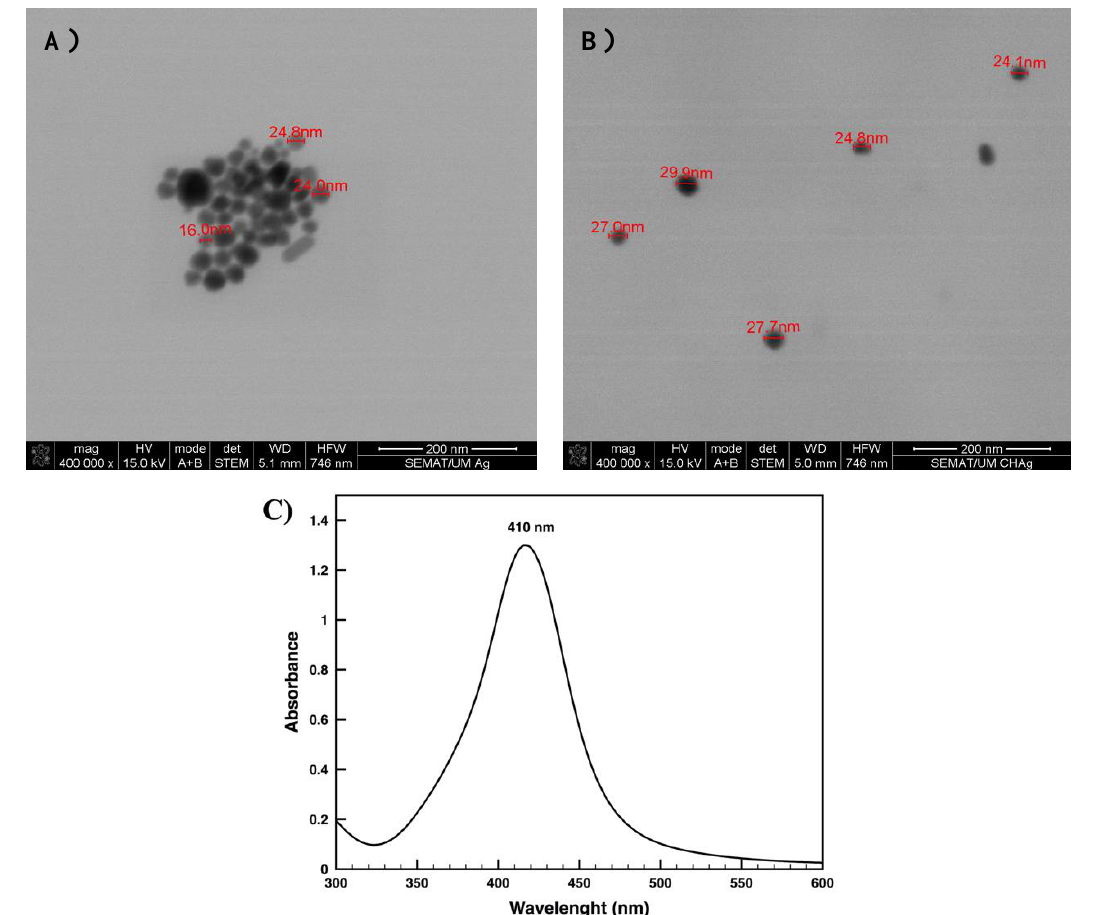
Figure 2. STEM images of the AgNPs aqueous colloidal solution depicting the synthesized silver nanoparticles in the absence ( A ) and the presence ( B ) of chitosan and ( C ) UV–Vis spectra of the AgNPs aqueous colloidal solution.